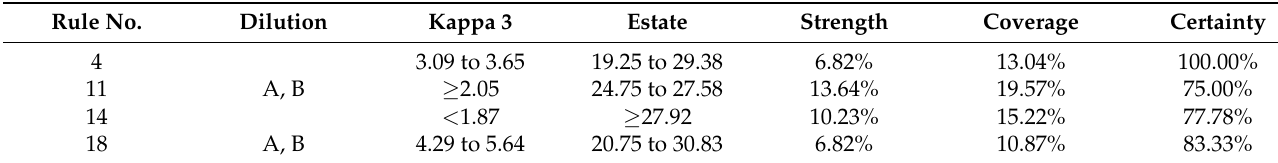
Table 8. Performance of rules 4, 11, 14 and 18 in validation.